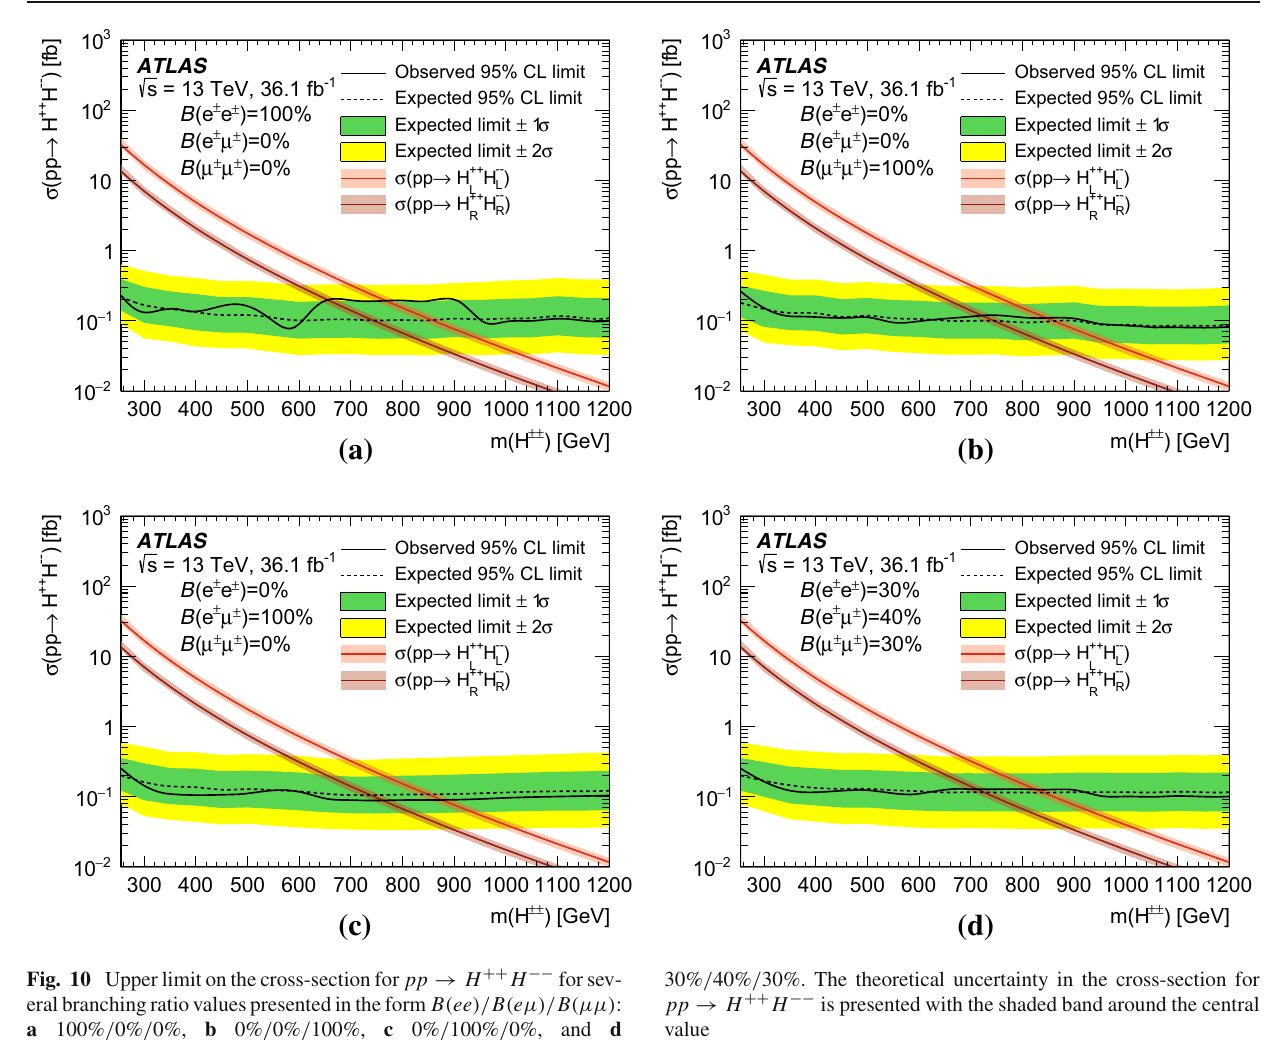
boson mass for all branching ratio combinations that sum to L